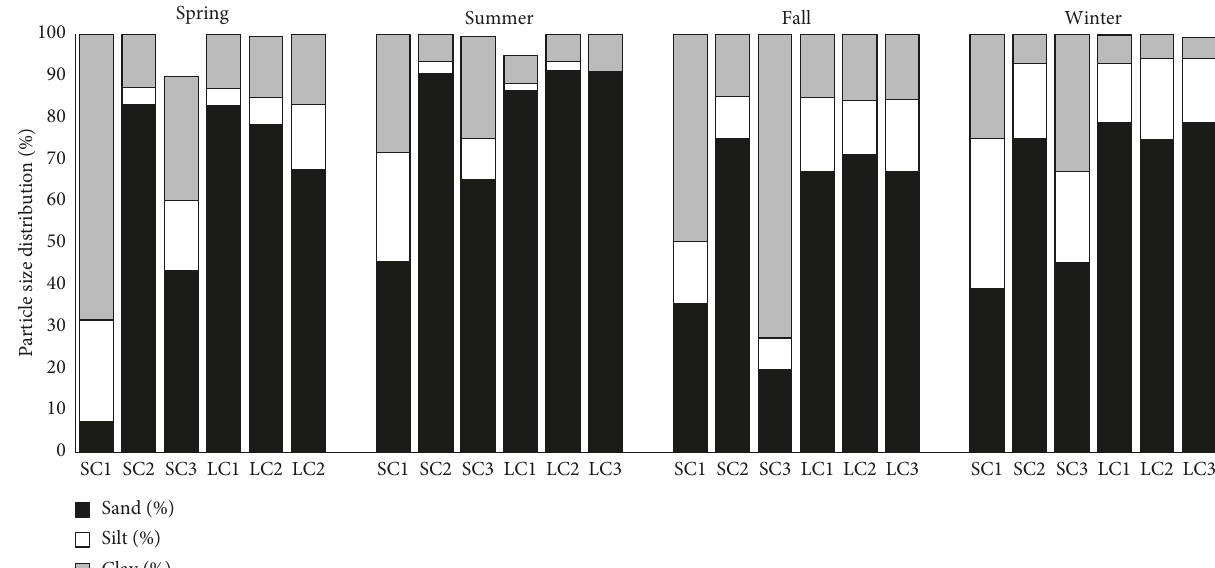
Figure 2: Particle size distribution of the river and lake sediments at different